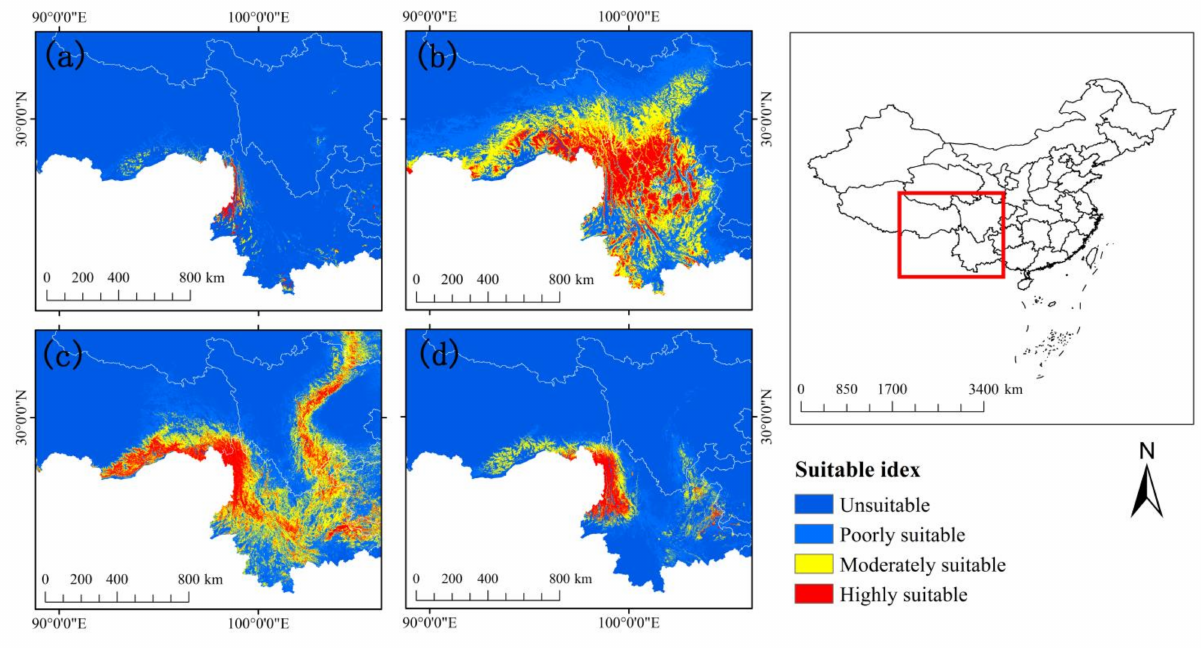
Figure 2. The potential current distribution of four Rhododendron species: ( a ) R. protistum , ( b ) R. rex subsp. rex , ( c ) R. praestans , ( d ) R. sinogrande